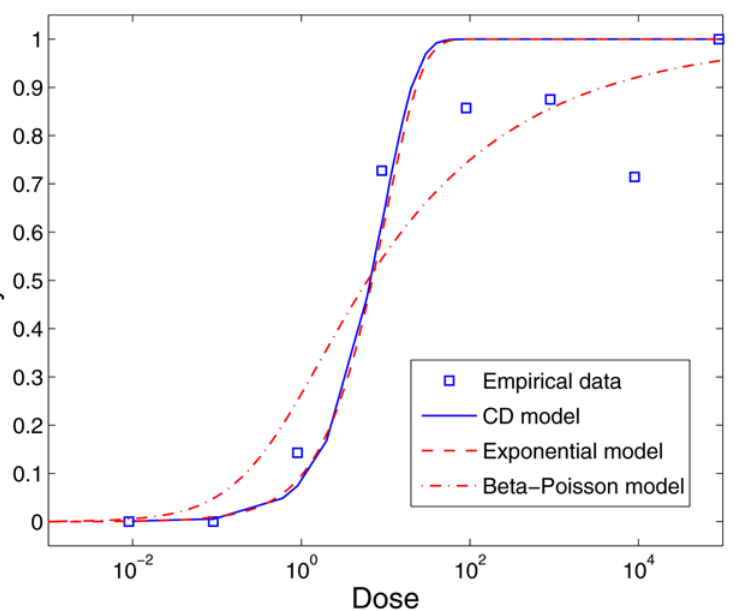
Figure 6. Dose-response curves based on the Exponential Model ( EM ), the Beta-Poisson model ( BP ) and the Cumulative Dose model ( CD ) compared to the experimental dataset for Rotavirus (squares). The estimated parameters are ^ rr ~ 1 : 0 | 10 { 1 for the Exponential n model, ^ aa , ^ bb